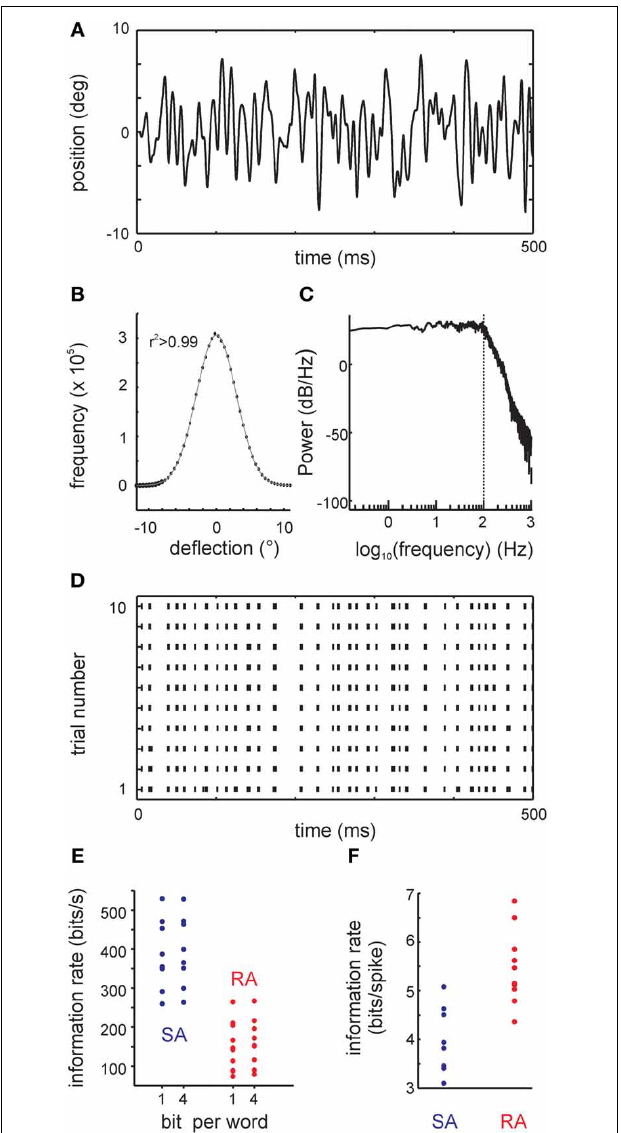
FIGURE 2 | The filtered white noise stimulus and results obtained with a classical information theoretical analysis: the direct method (DM). (A) Example trace of the whisker’s position. (B) The distribution of positions (circles) and the fit to a Gaussian (line). The coefficient of determination of the fit was r 2 > 0 . 99. (C) The stimulus power spectrum showing a flat density below 100Hz (vertical dotted line). Above 100Hz, there is a smooth roll-off. (D) Responses to the filtered white noise stimulus are very precise as demonstrated by the raster plot of one example primary afferent [response to the trace shown in (A) ]. (E) Information rate (bit/s) calculated using DM for all cells in the sample. Information rate with bin width of 1ms using 1 bit words (DM1.1) and 4 bit words (DM1.4) are shown. (F) Information rate converted into units of bits per spike